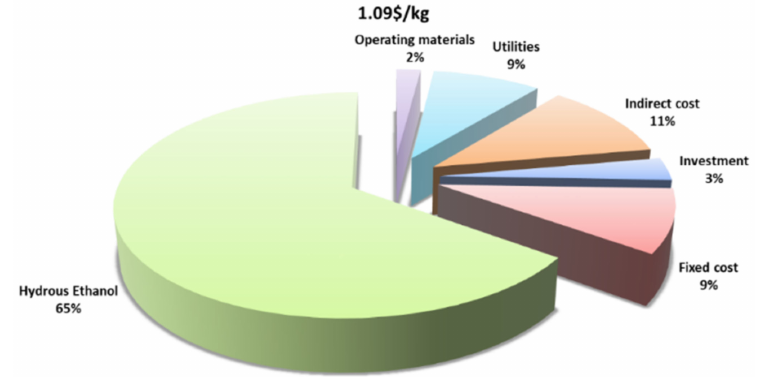
Figure 13. Levelized production cost